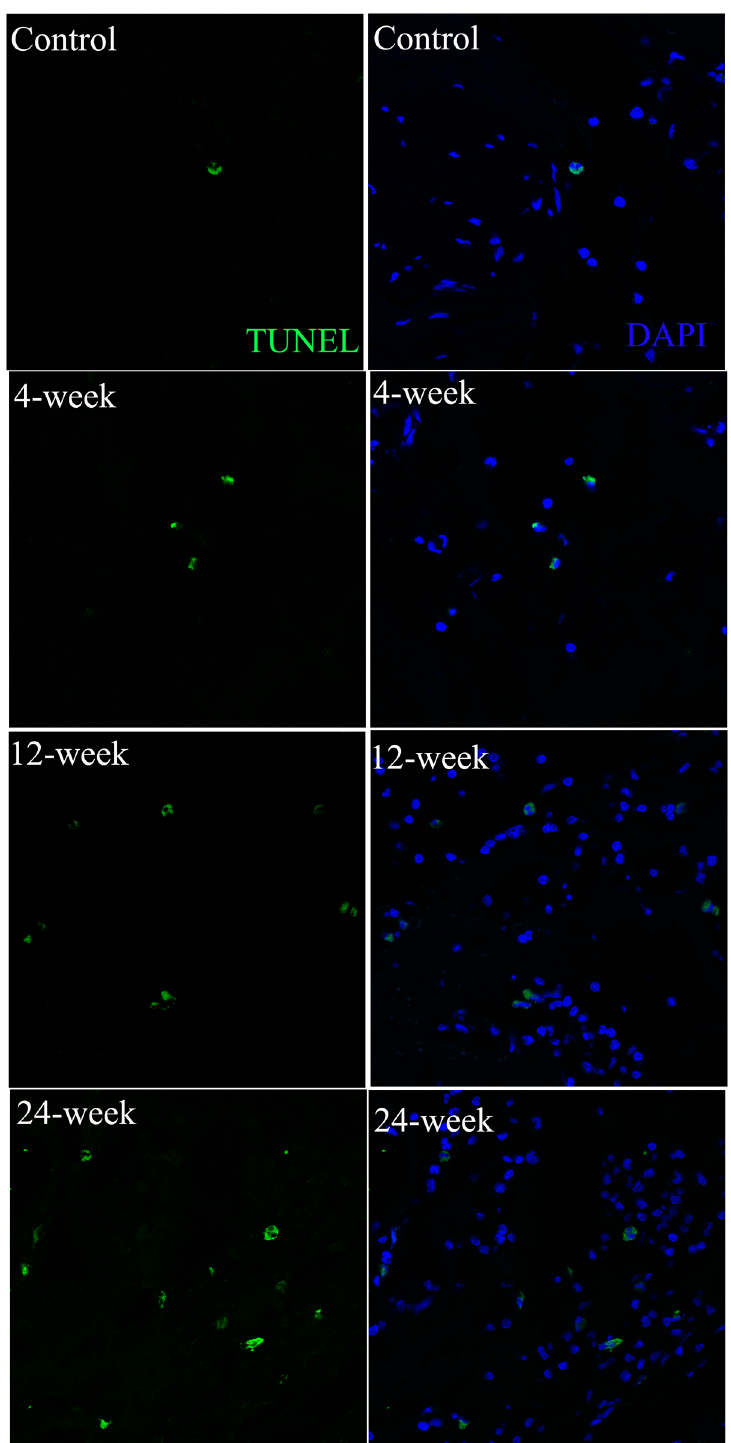
Fig 5. Analysis of apoptosis-positive cells by TUNEL stain. The corpus cavernosum was stained with TUNEL stain (green) and DAPI (blue) for the visualization of apoptotic cells and cell nuclei, respectively. The result showed the increase of the number of apoptosis-positive cells from control to 4-week, to 12-week and to 24-week. Magnification is x800.